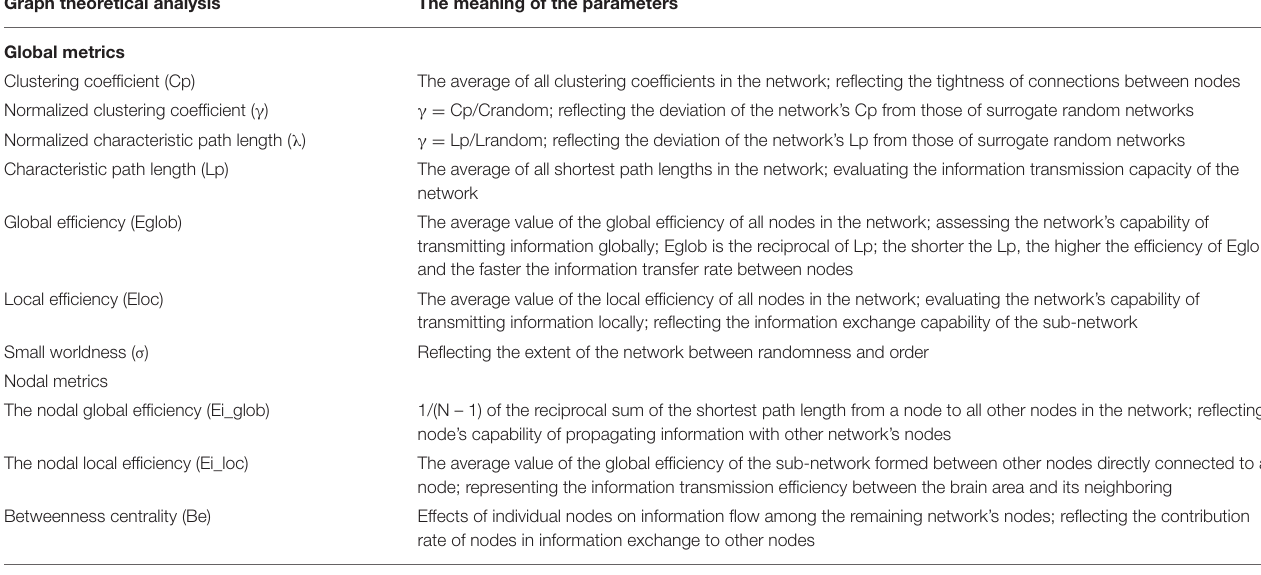
TABLE 1 | Global and nodal metrics for graph theoretical analysis.